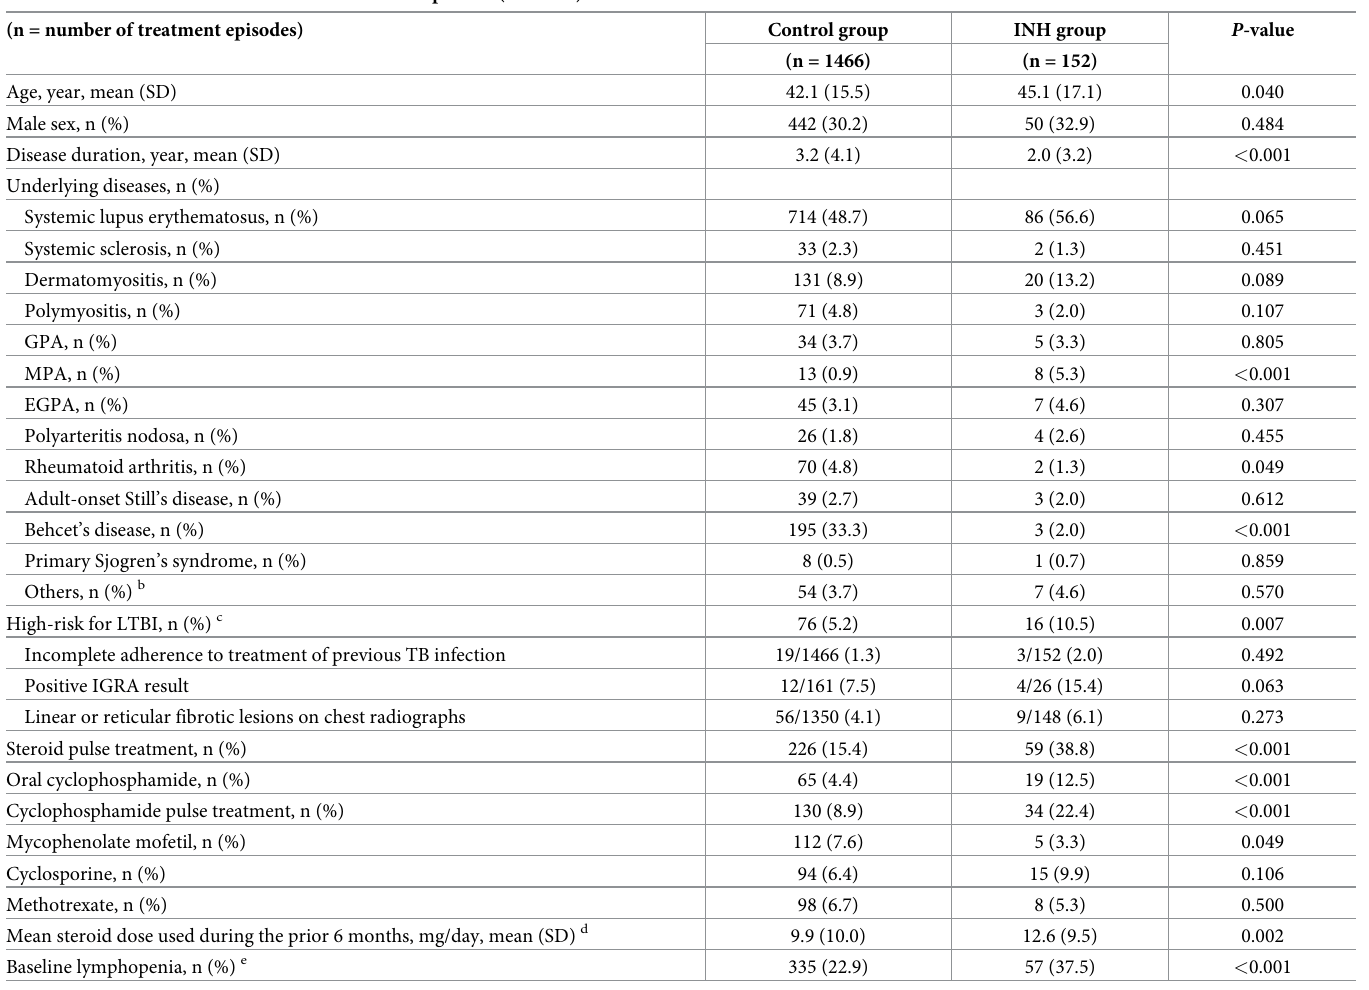
Table 1. Baseline a characteristics of the treatment episodes (n =